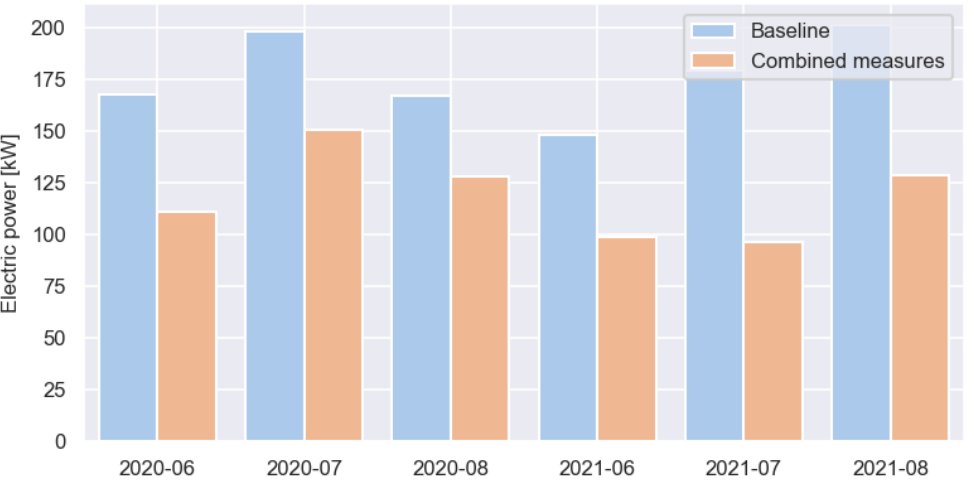
Figure 18. Average chilled water system electric power per month for the baseline and the combined measures during summer 2020 and 2021.